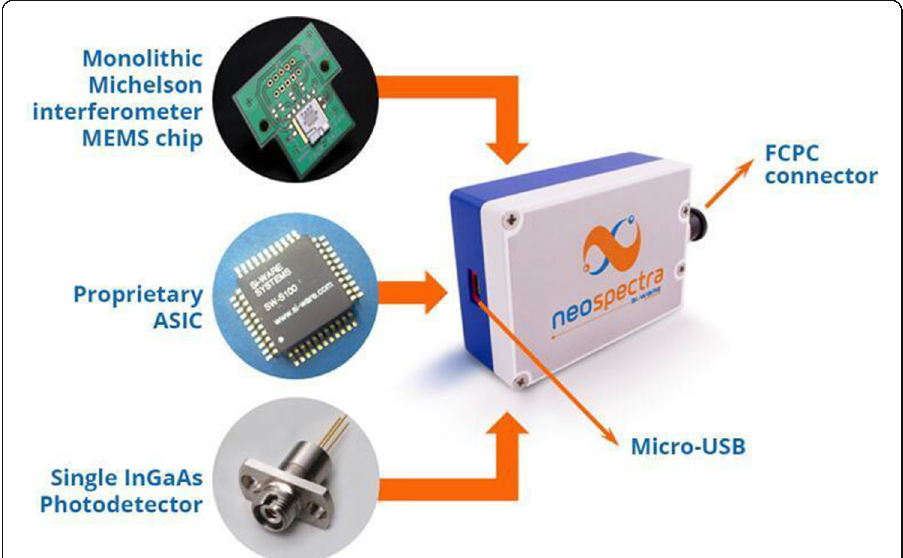
Fig. 1 Physical image of MEMS sensor (picture from